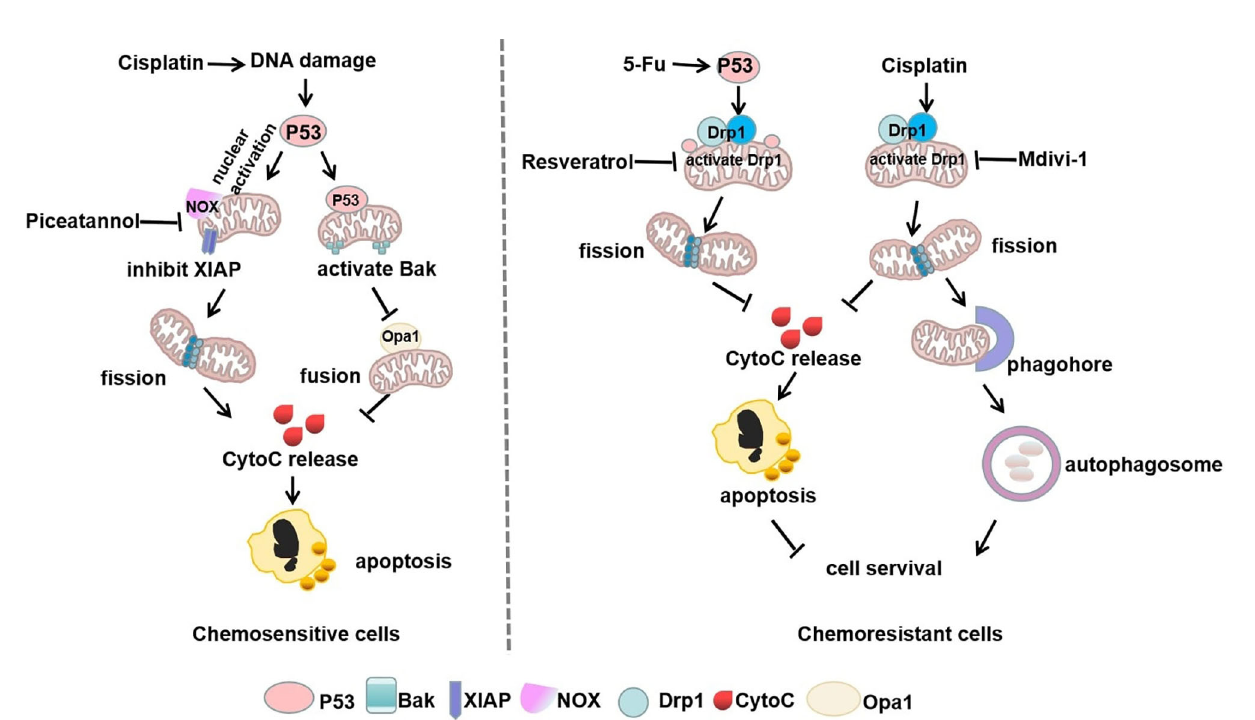
FIGURE 3 | Mitophagy and p53 in mitochondrial shaping protein-regulated chemotherapy. In chemosensitive cells, cisplatin-induced DNA damage exerts dual functions of p53 nuclear activation and mitochondrial translocation, which drives mitochondria-shaping proteins to promote mitochondrial fi ssion and inhibit fusion, thereby increasing apoptosis. However, chemotherapeutic drugs can stimulate p53 mitochondrial translocation or directly increase mitochondrial fi ssion by activation of Drp1, thus promoting autophagy to escape apoptosis in chemoresistant